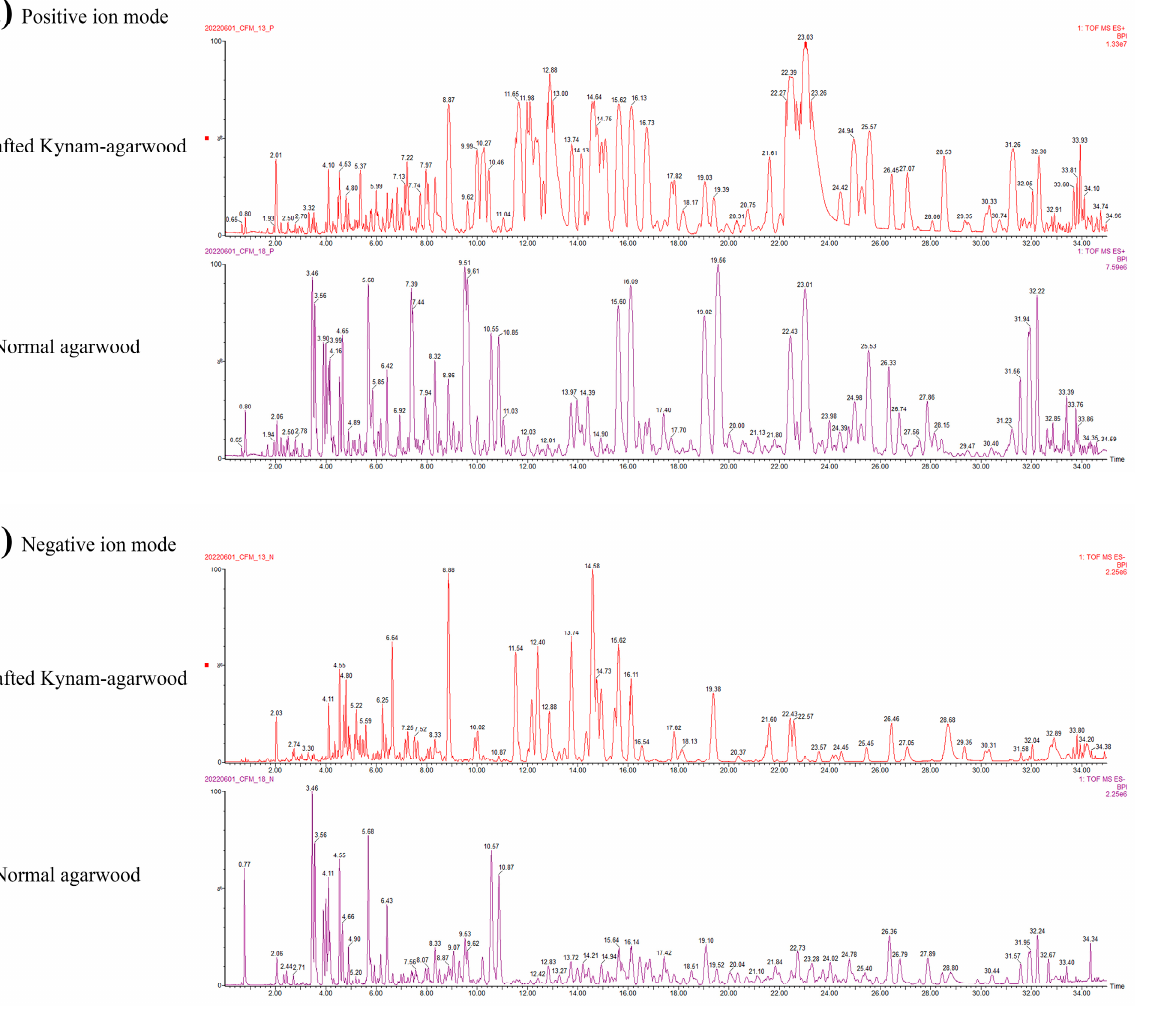
Figure 3. BPI plots of positive ion mode ( a ) and negative ion mode ( b ) of the ethanol extracts of two representative samples of